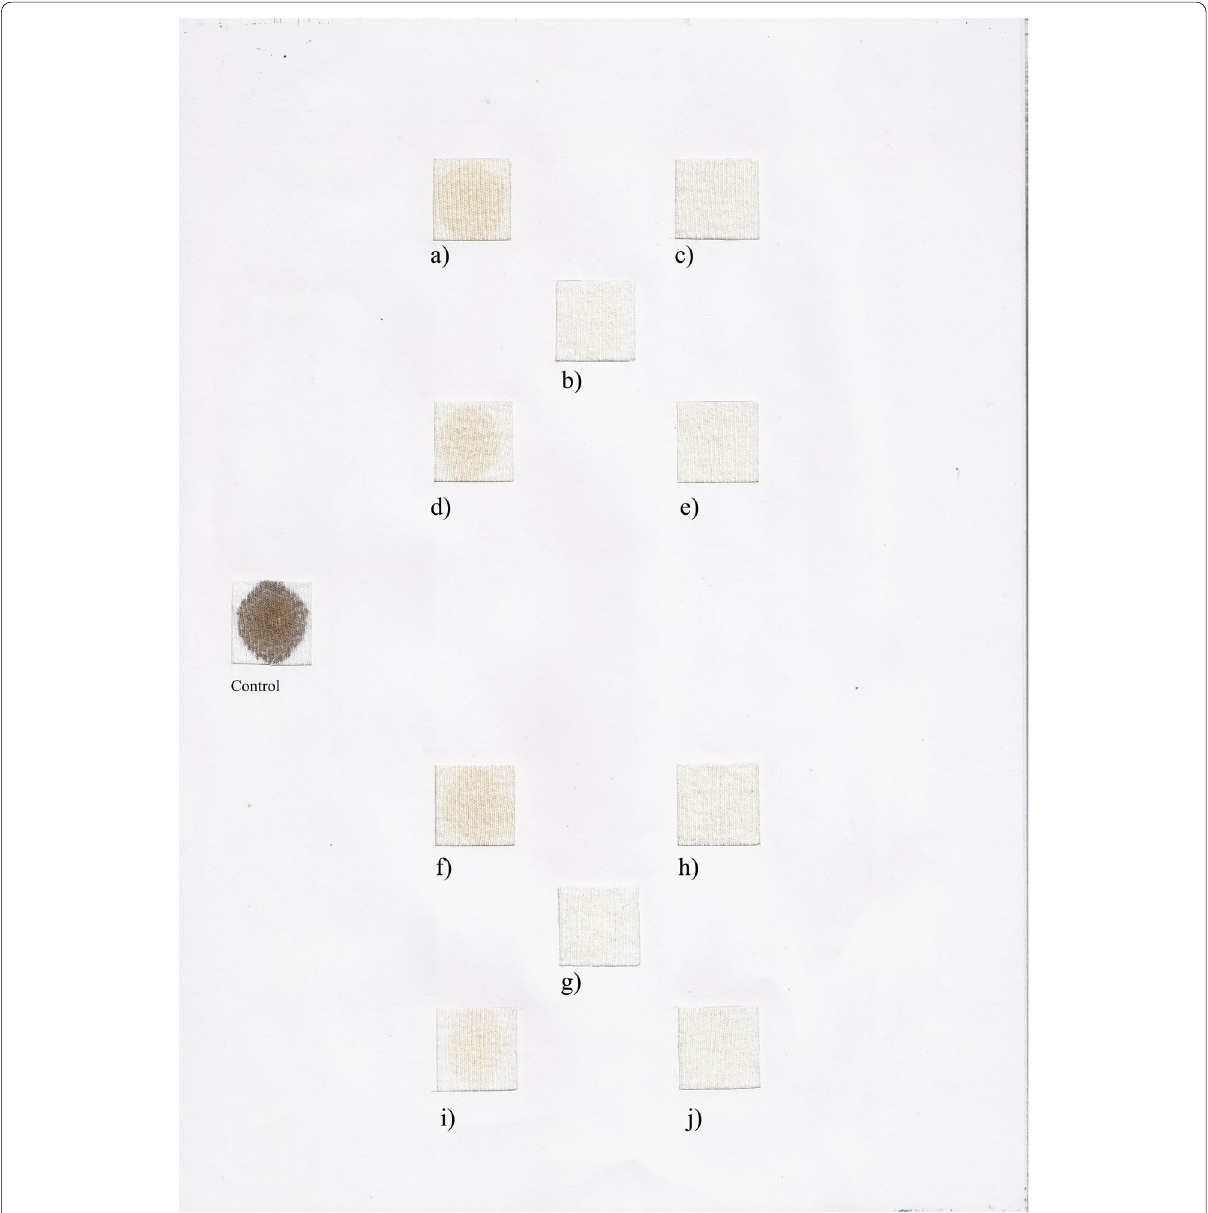
Fig. 6 Washing performance analysis of the Pedobacter sp. 3.14.7 enzyme preparation in the presence of the commercial detergent Skip. Analysis was done at 20 °C ( a – e ) and 50 °C ( f – j ), for 40 min ( a – e and g – i ) and 80 min ( f – j ). Cloth washed with tap water ( a , d , f , and i ); b , g cloth washed with Skip. In c , e , h , and j , the cloth was washed with endogenous‑enzyme inactivated Skip, supplemented with the crude enzyme with keratinase